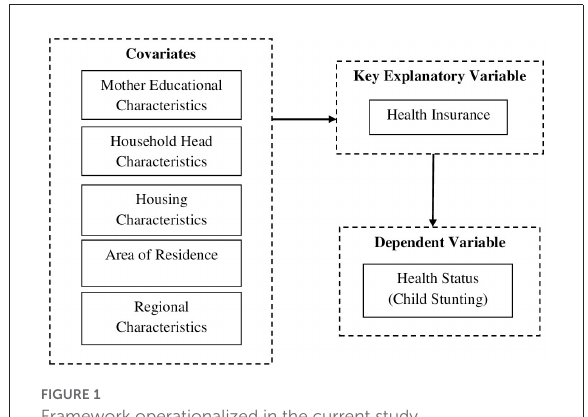
FIGURE1 Framework operationalized in the current study.